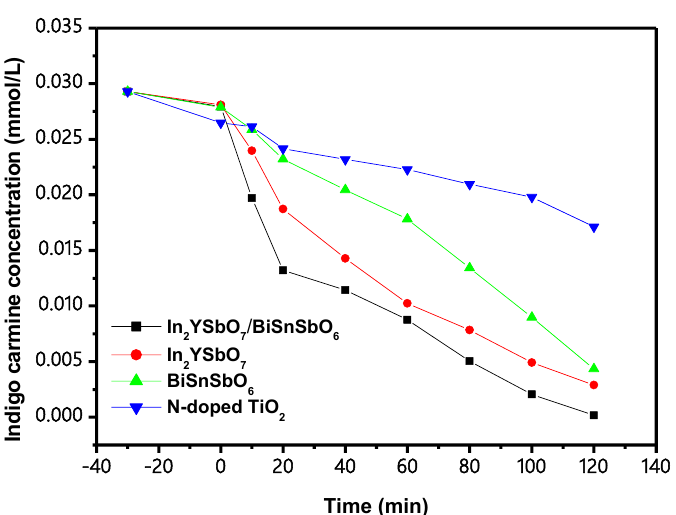
Figure 16. Concentration variation curves of IC during PCD of IC with IBH as a catalyst or with In 2 YSbO 7 as a catalyst or with BiSnSbO 6 as a catalyst or with N-TiO 2 as a catalyst under VLGI. Figure 17 shows the CCC of total organic carbon (TOC) at the time of PCD of IC in DW with IBH as a catalyst or with In 2 YSbO 7 as a catalyst or with BiSnSbO 6 as a catalyst or with N-TiO 2 as a catalyst under VLGI. Figure 17 shows that the ROR of TOC within DW reached 93.10%, 84.26%, 80.02% and 35.50%, respectively, after VLGI-120M when IBHP, In 2 YSbO 7 , BiSnSbO 6 and N-TiO 2 were used for degrading IC. Finally, by analyzing the results regarding the ROR of TOC at the time of IC degradation, the ROR of TOC with IBHP was the best among the above four catalysts. The obtained results also showed that the ROR of TOC during IC degradation using In 2 YSbO 7 was much higher than that using BiSnSbO 6 or N-TiO 2, implying that IBHP possessed the highest mineralization rate during IC degradation compared with In 2 YSbO 7 or BiSnSbO 6 or N-TiO 2 .